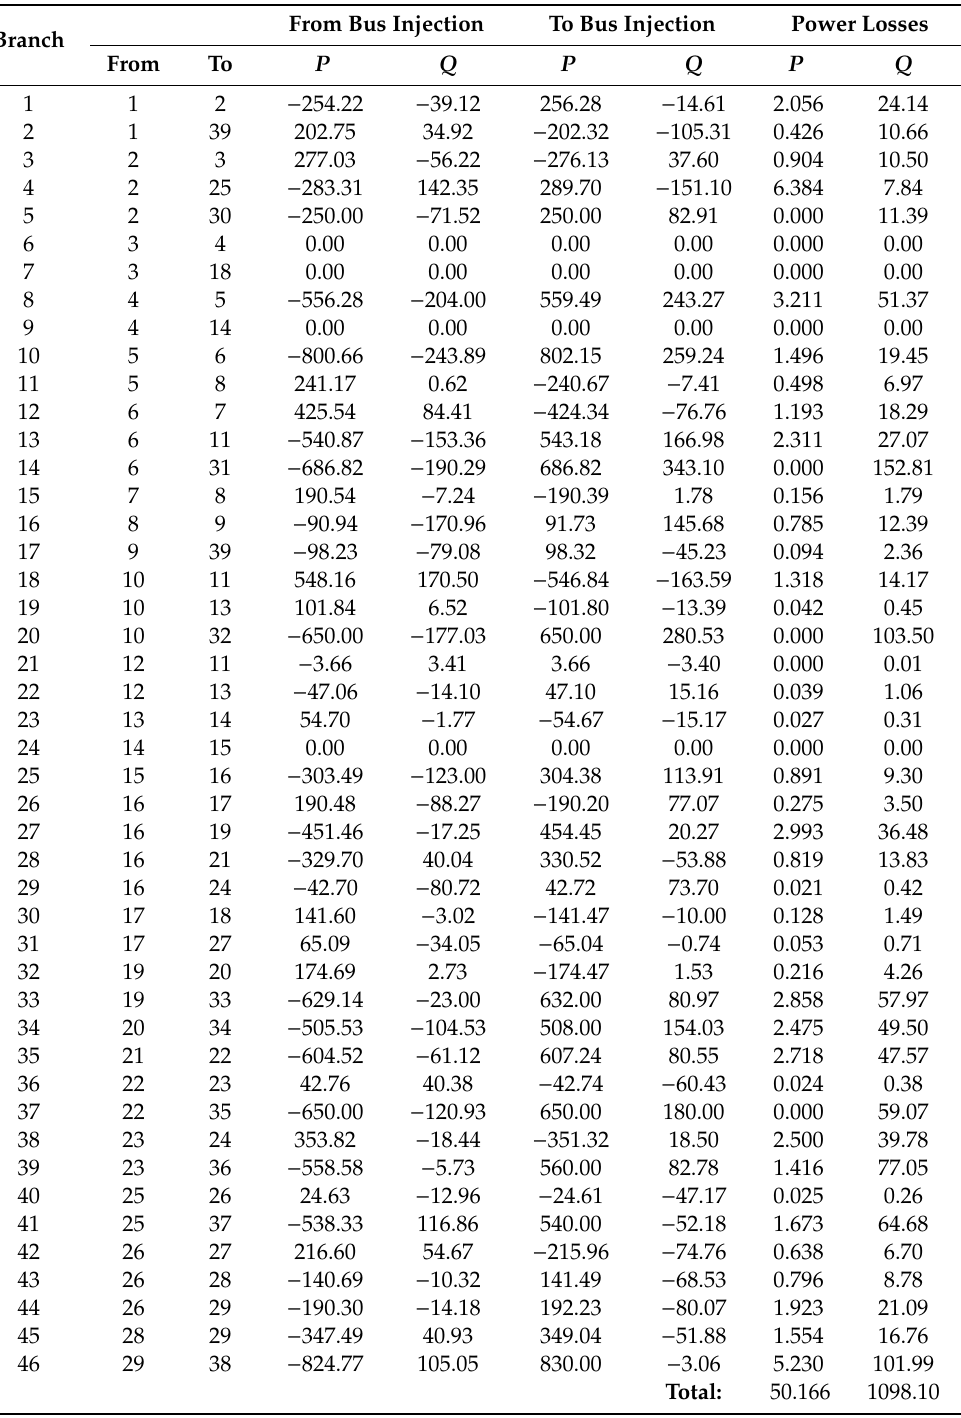
Table A51. Results of Mixed AC / DC PF calculations in Case 7-6. AC branch